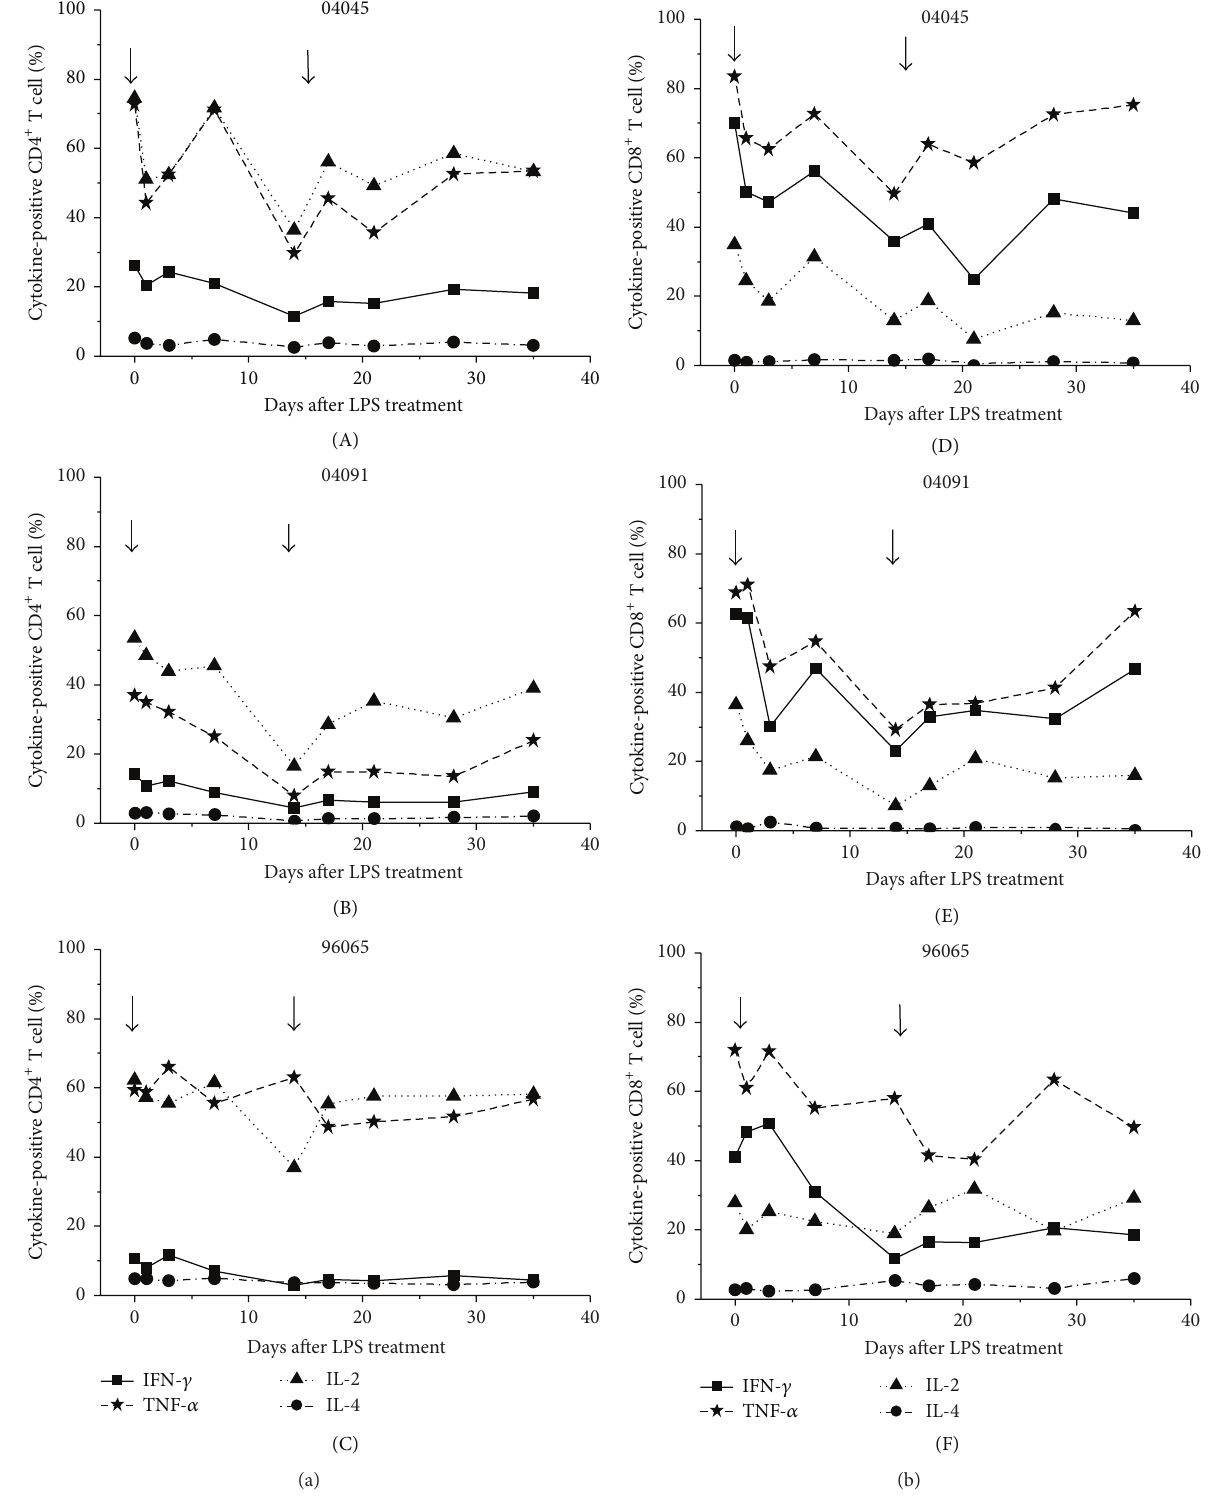
Figure 5: Cytokine profile of CD4 + and CD8 + T cells in response to PMA and ionomycin stimuli. PBMCs were isolated and stimulated by PMA and ionomycin as described in the Materials and Methods and analyzed by flow cytometry for intracellular production of IFN- 𝛾 , TNF- 𝛼 , IL-2, and IL-4. Proportion of cytokine-producing CD4 + T cells in response to stimulus (a); proportion of cytokine-producing CD8 + T cells in response to stimulus